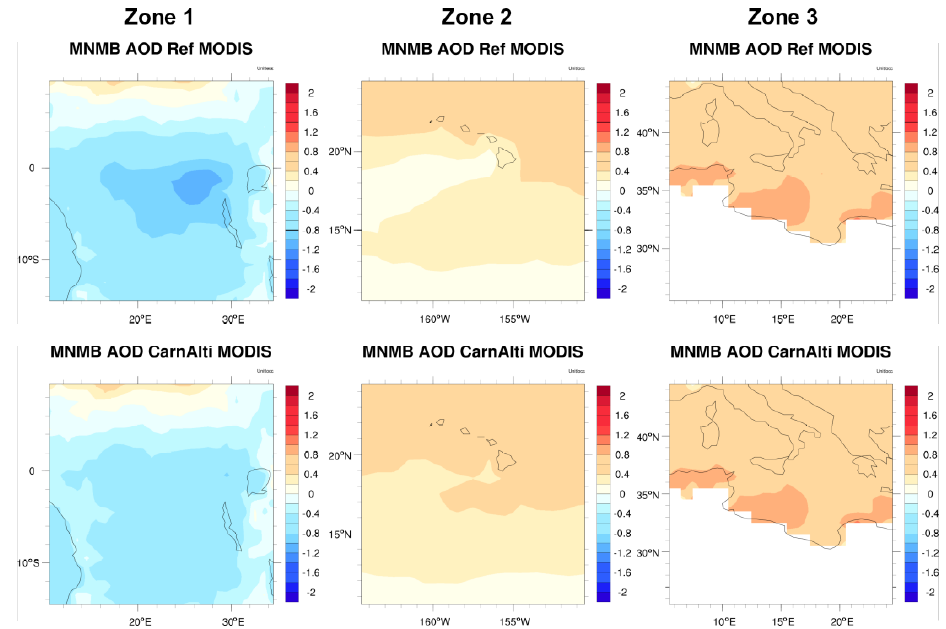
Figure 6. Maps of the 2013 annual MNMB of the REF and CARNALTI simulations against MODIS observations at the specific zones. Table 4. Global and local (zones 1, 2 and 3) 2013 annual mean concentrations in the REF, CARN and CARNALTI simulations. Gases are in moles and aerosols in